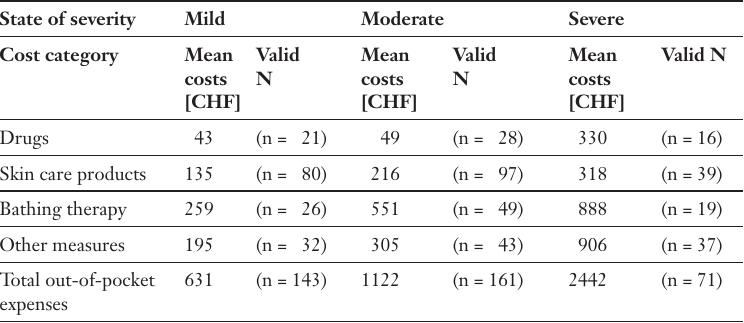
Out-of-pocket expenses per patient per year according to state of severity.